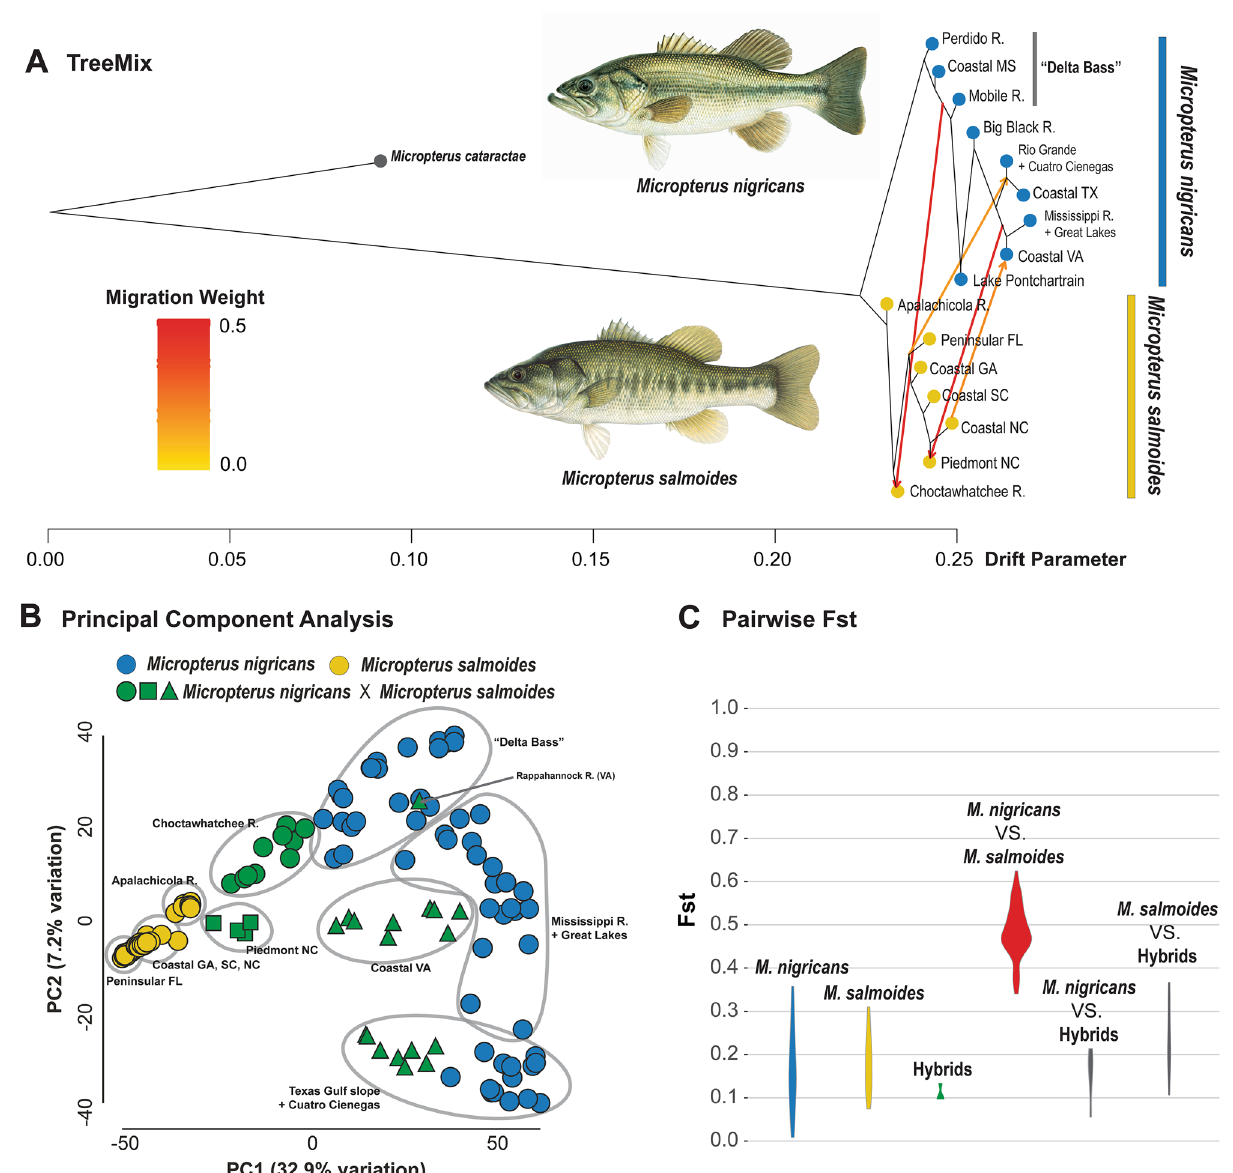
Figure 5. ( a ) Migration edges between Micropterus nigricans and M. salmoides , inferred from TreeMix analysis. Arrows show relative magnitude and direction of gene flow among populations of the Largemouth Bass complex. ( b ) Principal component analysis (PCA) of genetic variance for species of the Largemouth Bass complex. Grey ellipses indicate major geographic populations or lineages of the Largemouth Bass complex. We separate populations that are genetically admixed between Micropterus nigricans and Micropterus salmoides by origin of genetic admixture: presumably natural secondary contract (green circles); uncertain (green rectangles); and human-mediated origin (green triangles). ( c ) Violin plots for ranges of pairwise Fst values among populations within Micropterus nigricans , M. salmoides , and genetic admixtures (Choctawhatchee and North Carolina Piedmont) and between each pair of the three groups. Pairwise Fst values between populations of Micropterus nigricans and M. salmoides are considerably higher than other pairs in comparison. Illustrations © Joseph R. Tomelleri, used with